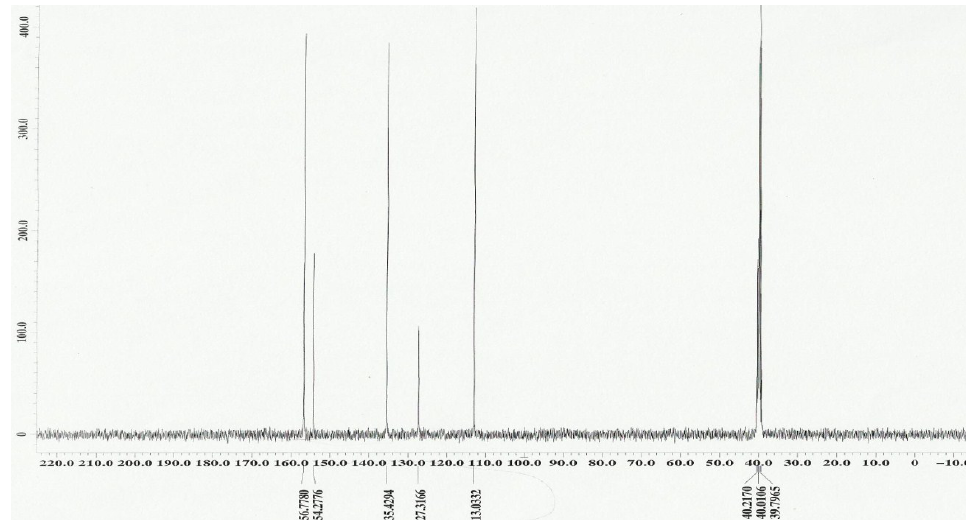
Figure 4 . Experimental 13 C-NMR of